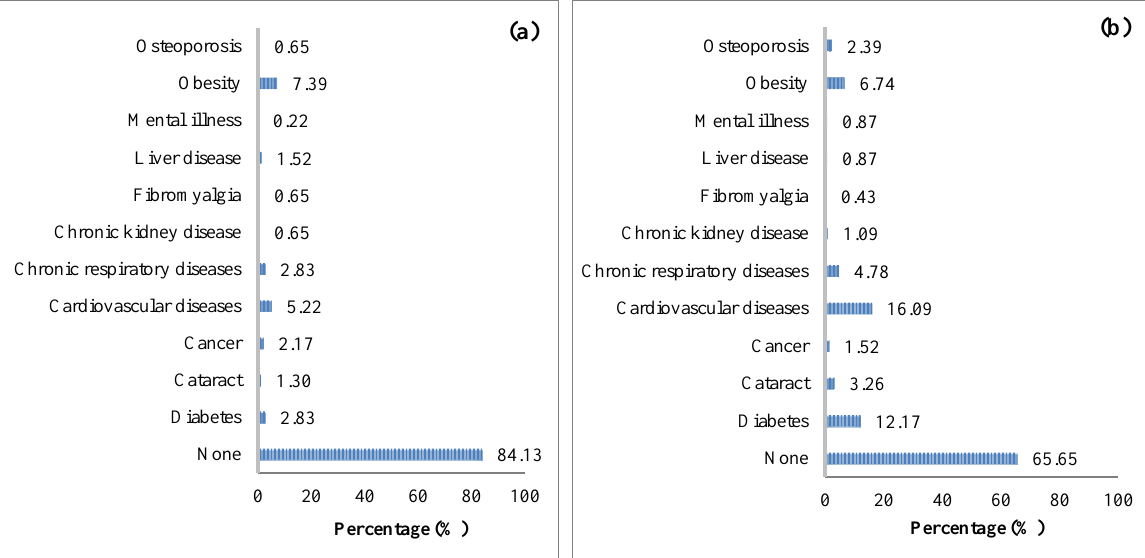
Figure 1. Prevalence of NCDs and Obesity within the surveyed population (a) and their families